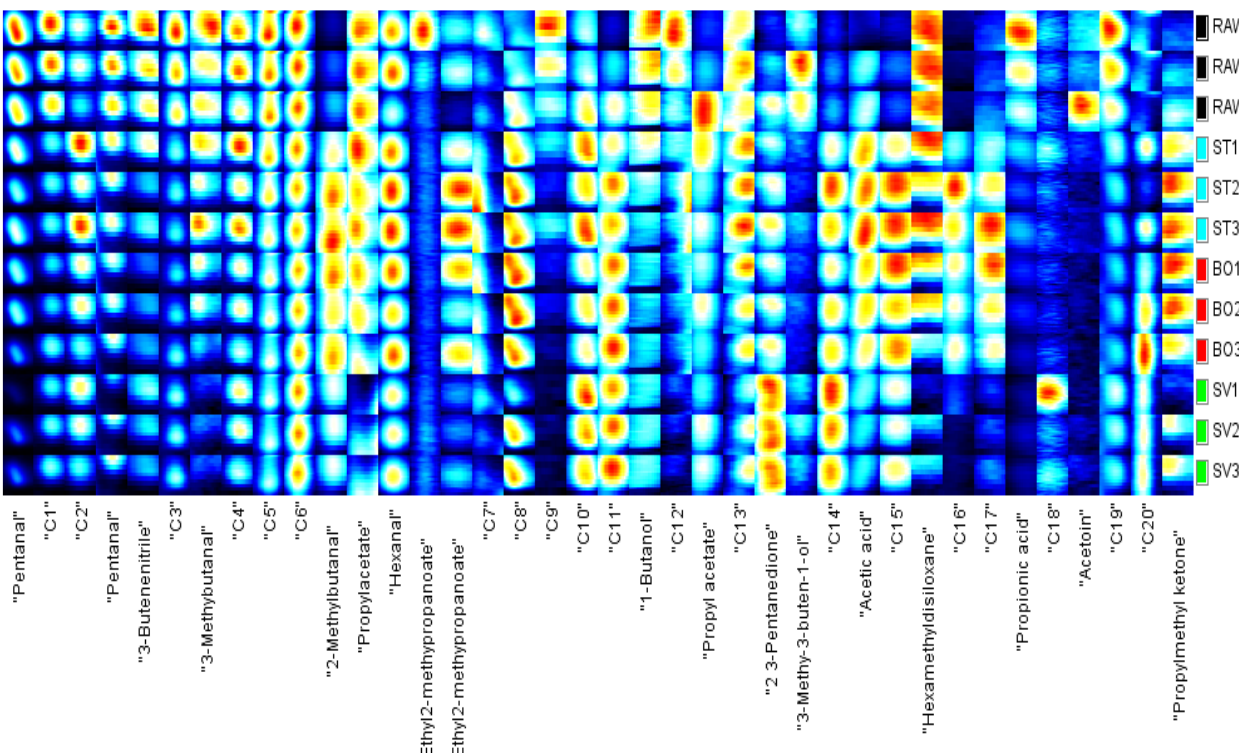
Figure 7. Contrast spectrum of volatile compounds in squid ( Symplectoteuthis oualaniensis ) mantle muscle from different cooking methods. The topographic plot of RAW was selected as a reference, while the plots of other samples were de- ducted from the reference. Each point on the spectrum represents a volatile component and its color indicates the signal intensity. Red indicates high intensity, and blue indicates low intensity. From left to right, the sample treatments were RAW, ST, BO, and SV, respectively. RAW: raw squid; ST: steaming; BO: boiling; SV: sous vide.